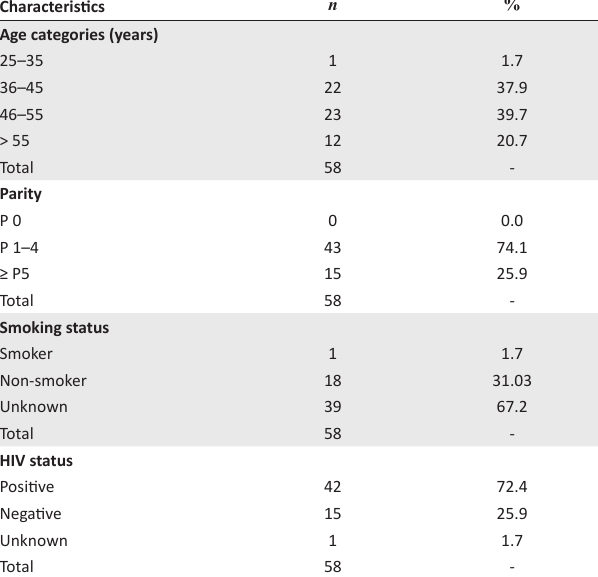
TABLE 1: Demographic